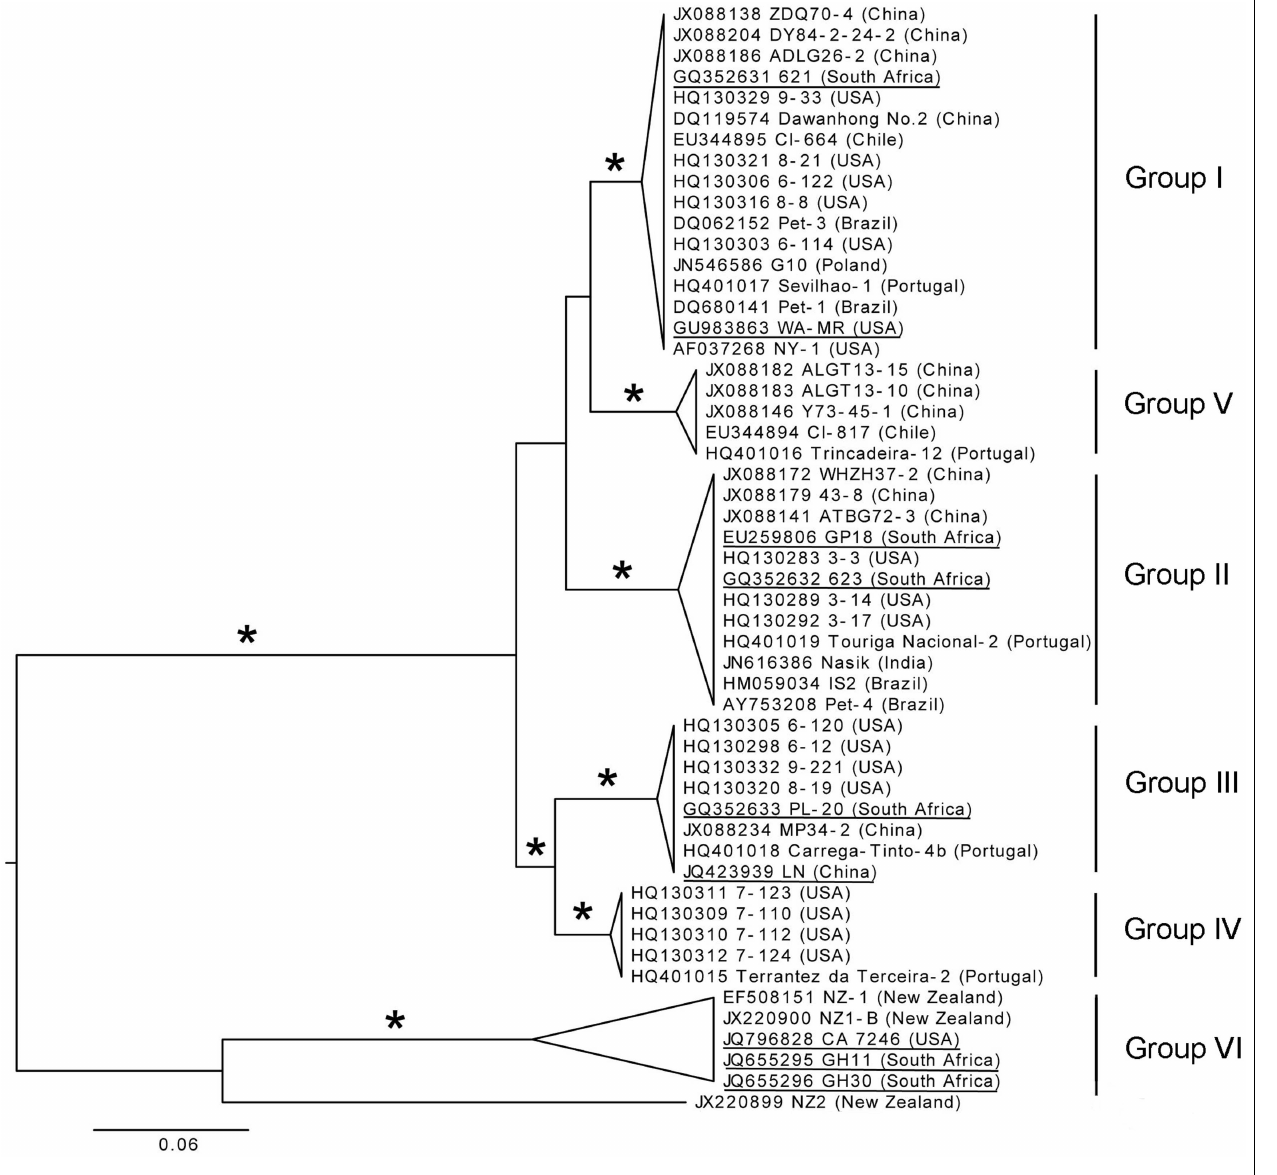
FIGURE 6 | Phylogenetic tree of full-length CP gene from representative GLRaV-3 isolates (Isolate NZ1, GenBank: EF508151, is a partial sequence). Proposed GLRaV-3 variant groups are shown with roman numerals. Maximum likelihood tree is shown, but analyses with distance and maximum parsimony methods provide similar topology.The tree is midpoint